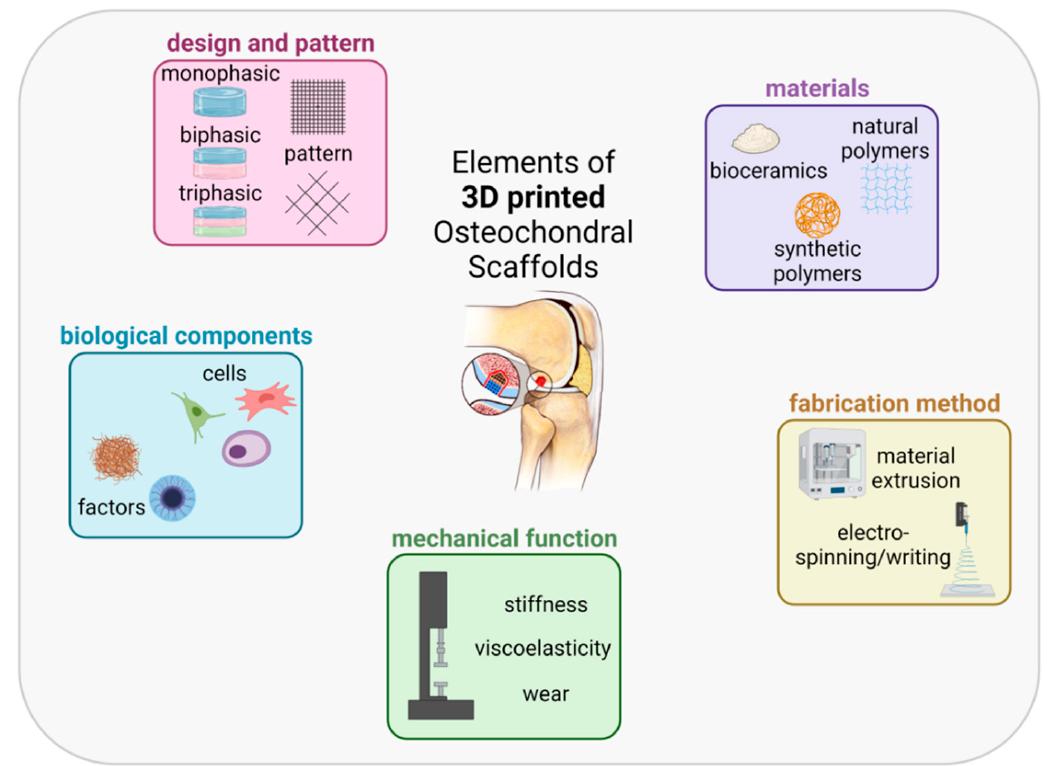
Figure 3. Elements of 3D printed OC scaffolds. We have identified five main domains of a 3D printed OC scaffold: materials (e.g., natural and synthetic polymers, bioceramics and hydrogels), fabrication method (e.g., material extrusion (ME), electro-spinning (ES), electrowriting and stereolithography (SLA), mechanical function, biological components (e.g., cells–chondrocytes, osteoblasts, stem cells and growth factors) the overall design (e.g., mono or multiphasic) and pattern of each 3D printed layer. Figure created with BioRender.com (10 October 2021).